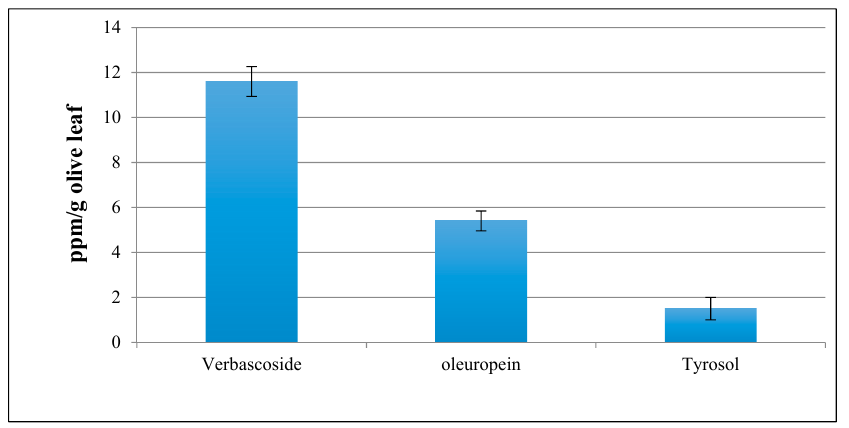
Figure 3. Olive leaf extract profile.